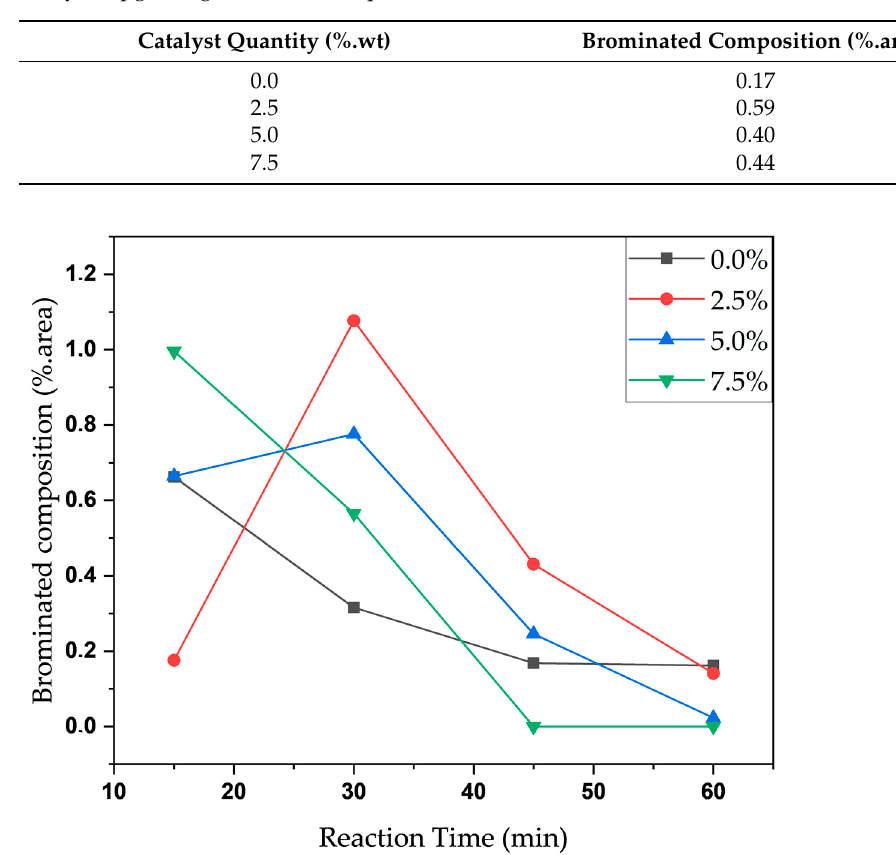
Table 8. Brominated compound composition of bio-oil obtained through thermal cracking and catalytic upgrading with Si–Al ash pellets at 450 ◦ C.